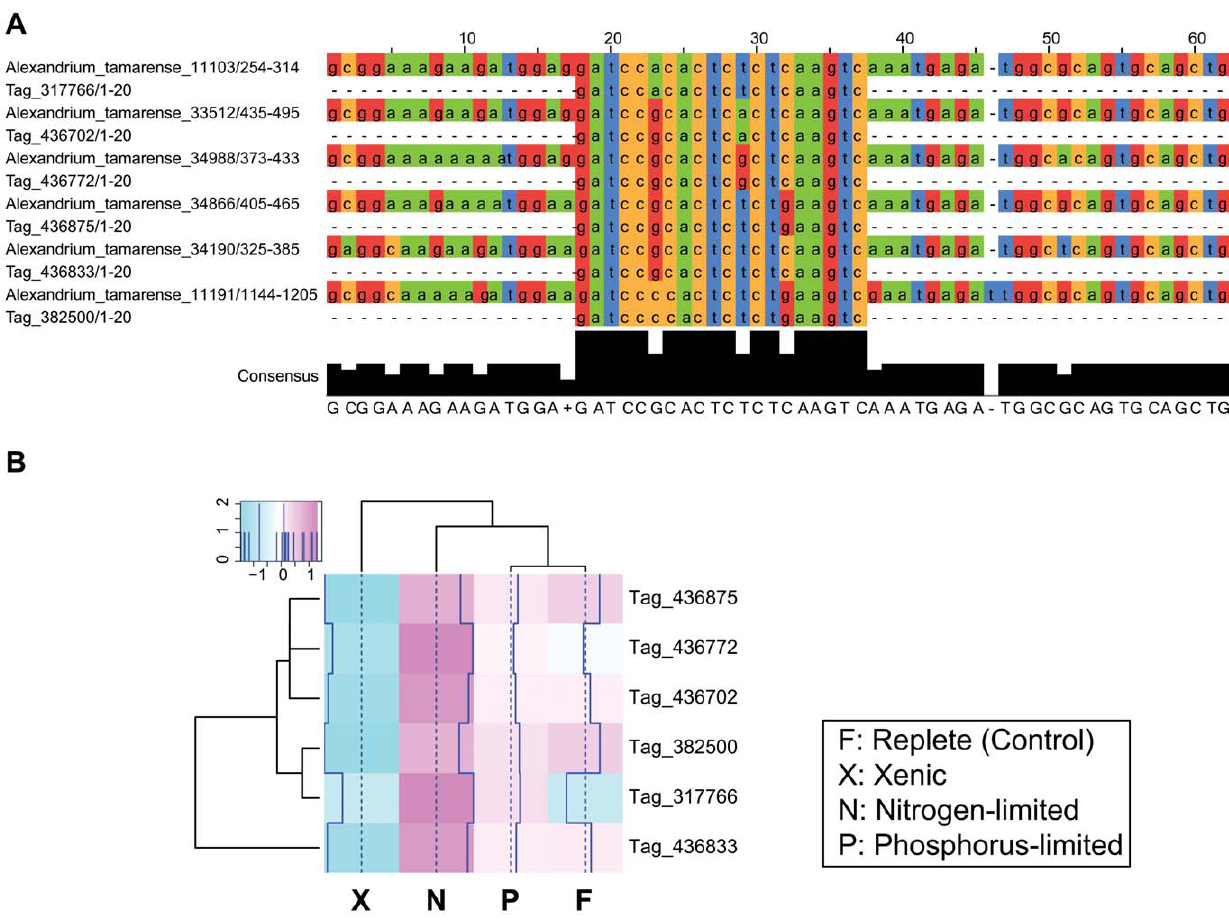
Figure 2. Co-regulation of elongation factor 1- a gene family members. (A) Multiple sequence alignment of six signatures and their matching ESTs. The six signatures contain one or two pairwise mismatches. The mismatches among the signatures co-segregate along with mismatches in the ESTs. (B) Heatmap of the expression of the six signatures.